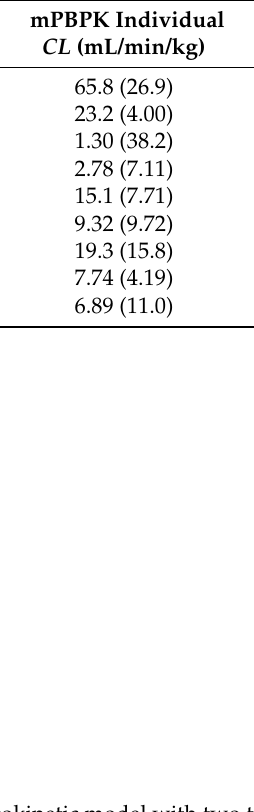
Figure 2. The minimal physiologically based pharmacokinetic model with two tissue compartments. A single K p value ( K p 1 = K p 2 ) was used in the joint fitting, while the cardiac output ( Q CO ) was divided into tissue blood flow to each compartment ( Q 1 + Q 2 = Q CO ) in the separate fittings. Symbols are defined in the text and in Table 2 and Table 5 (see Table 2. Pharmacokinetic parameters of metformin jointly fitted to the minimal physiologically based pharmacokinetic model across 9 species a,b .